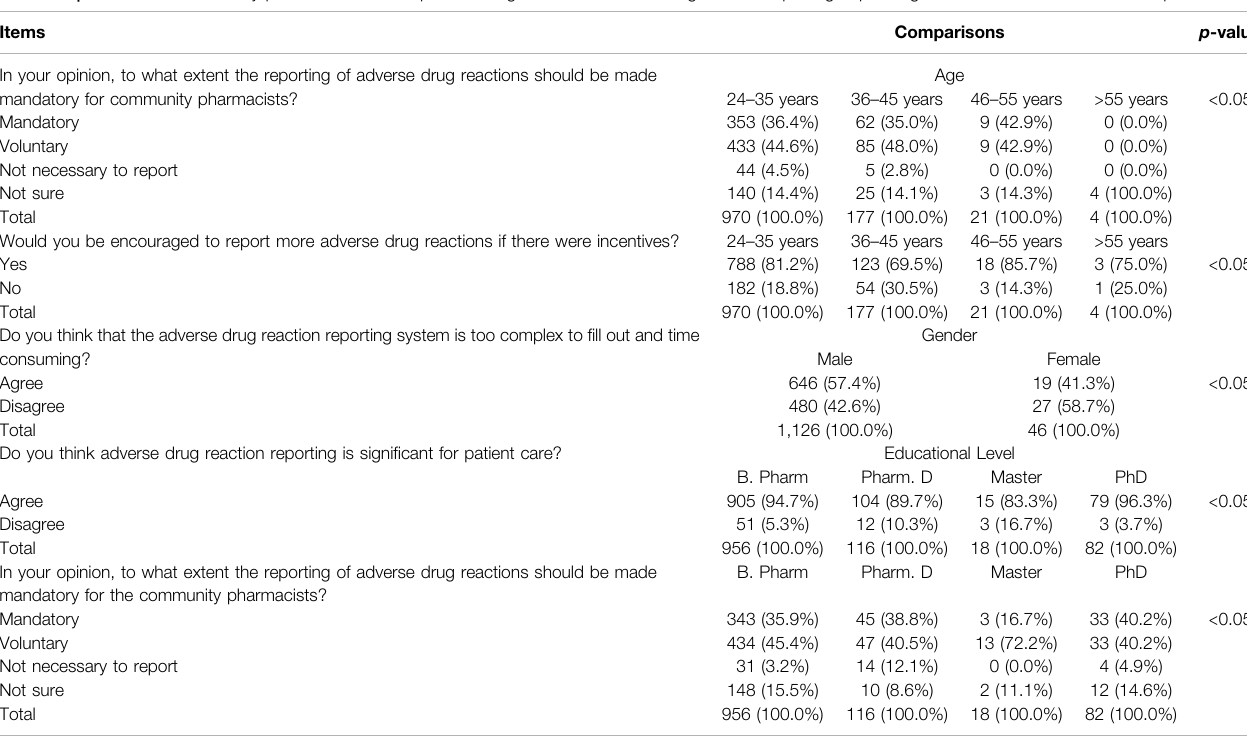
TABLE 3 | Attitudes of respondent pharmacists toward pharmacovigilance and ADR reporting.